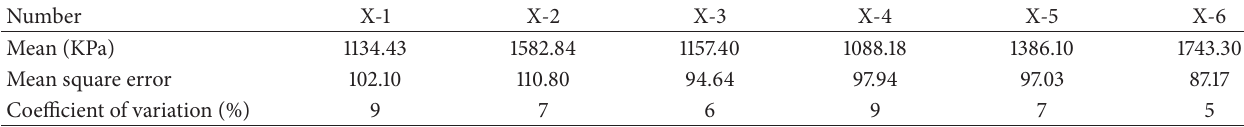
Table 6: Unconfined compressive strength